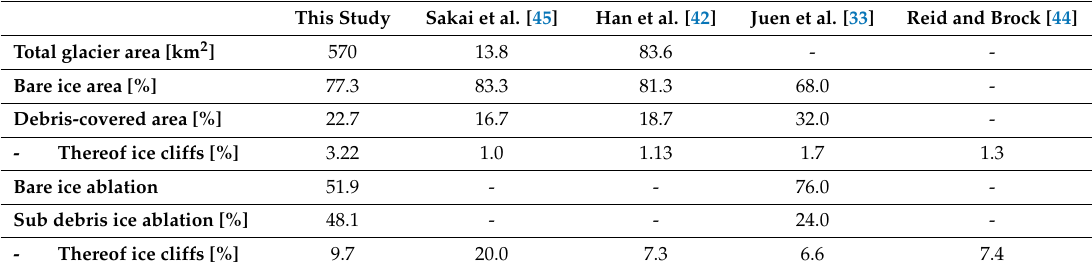
Table 7. Comparison of data from this study with other authors (this study: Sample 1 of the REMO scenario in Period